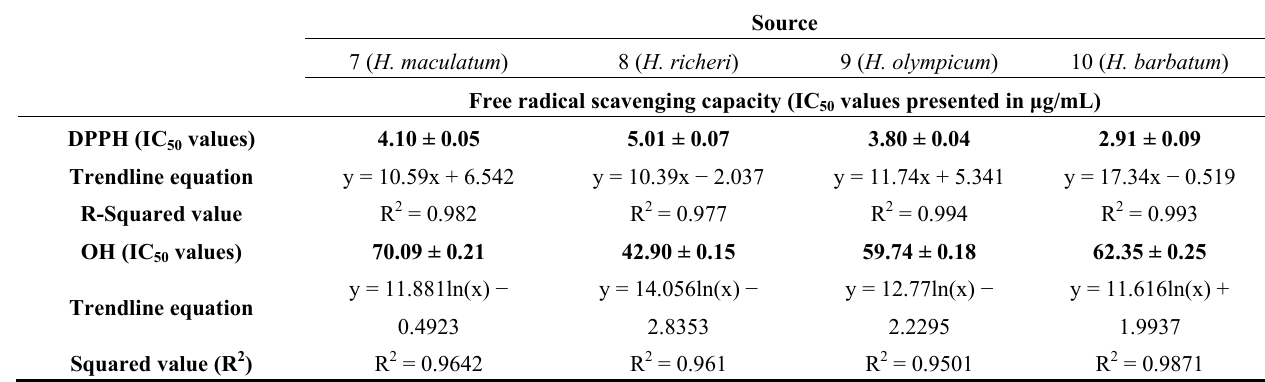
Table 4. Antioxidant potential of H. maculatum , H. richeri , H. olympicum and H. barbatum